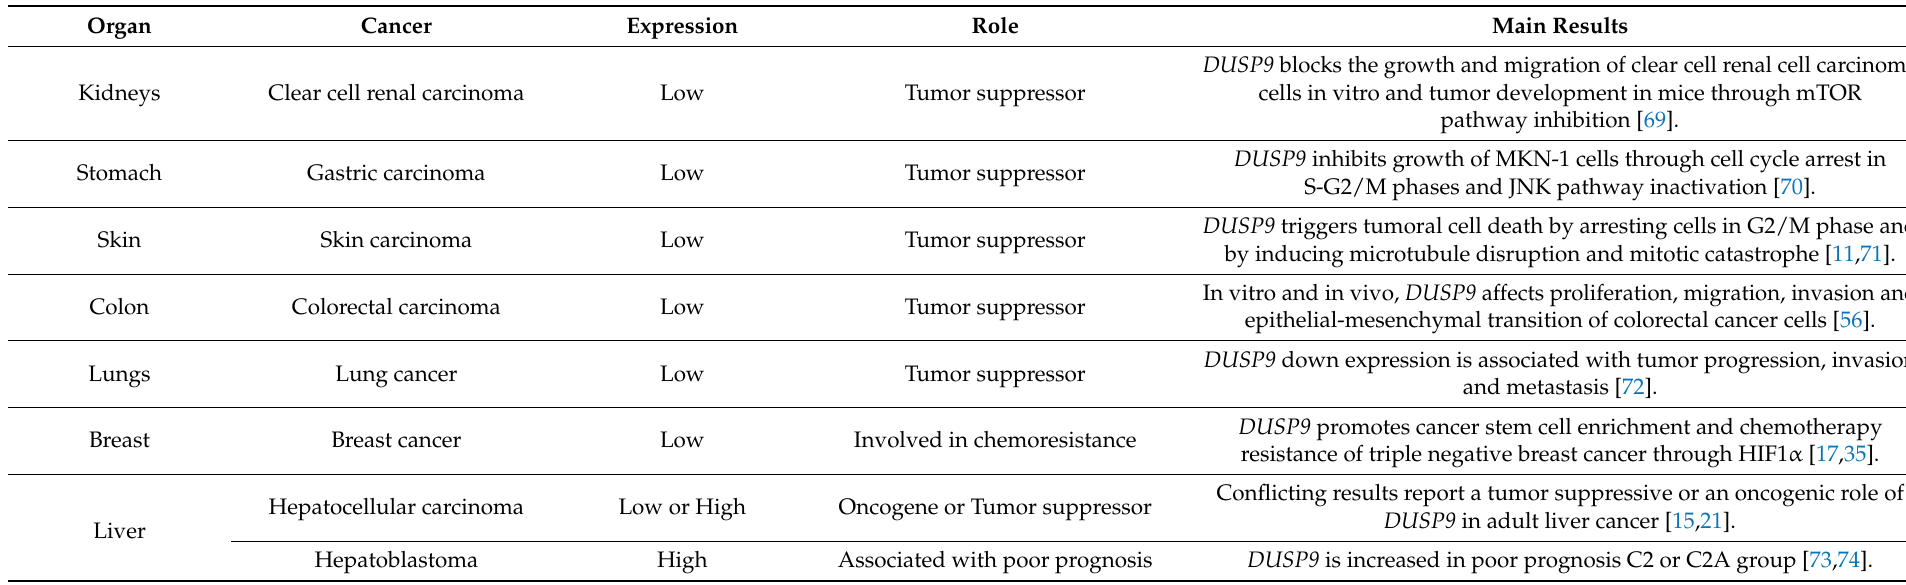
Table 2. Expression of DUSP9 in cancers versus non-tumoral tissues and main results from the